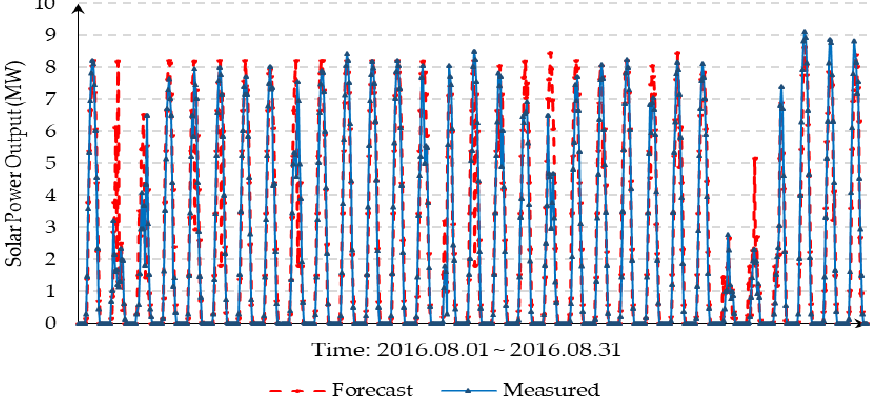
Figure 9. Comparison of the actual and forecast solar power in August 2016. Table 4. The normalized mean absolute error (NMAE) for each month of forecasting in 2016.